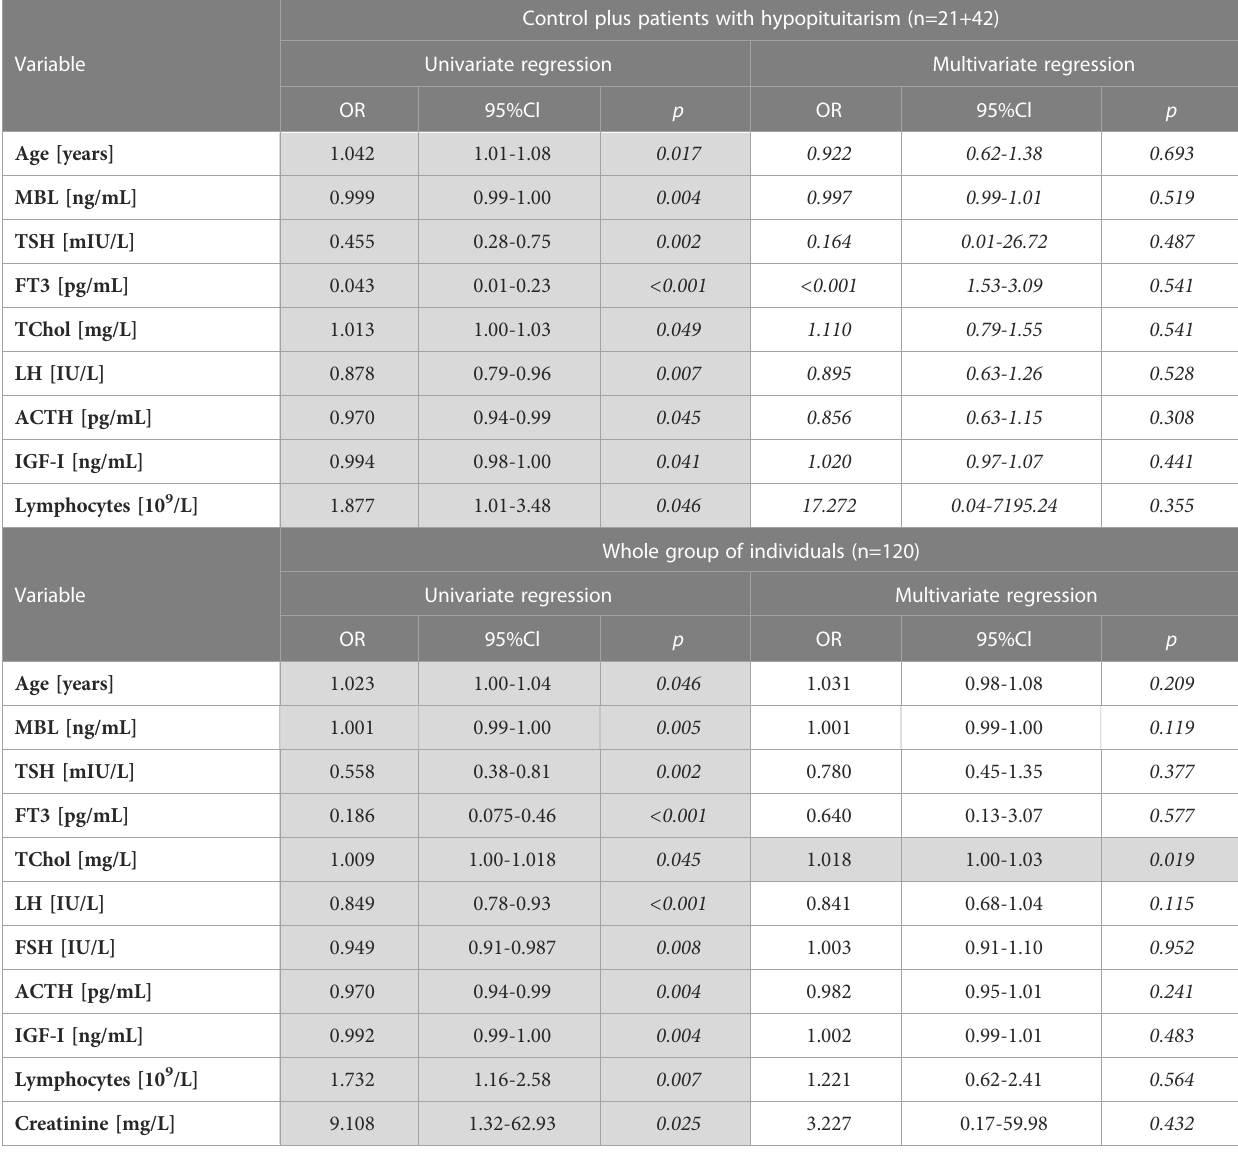
TABLE 5 Univariate and multivariate logistic regression analyses of hypopituitarism determinants (linear variables) performed in the following groups: Control plus patients with hypopituitarism (n=21+42) (above), and the whole group of individuals (n=120)